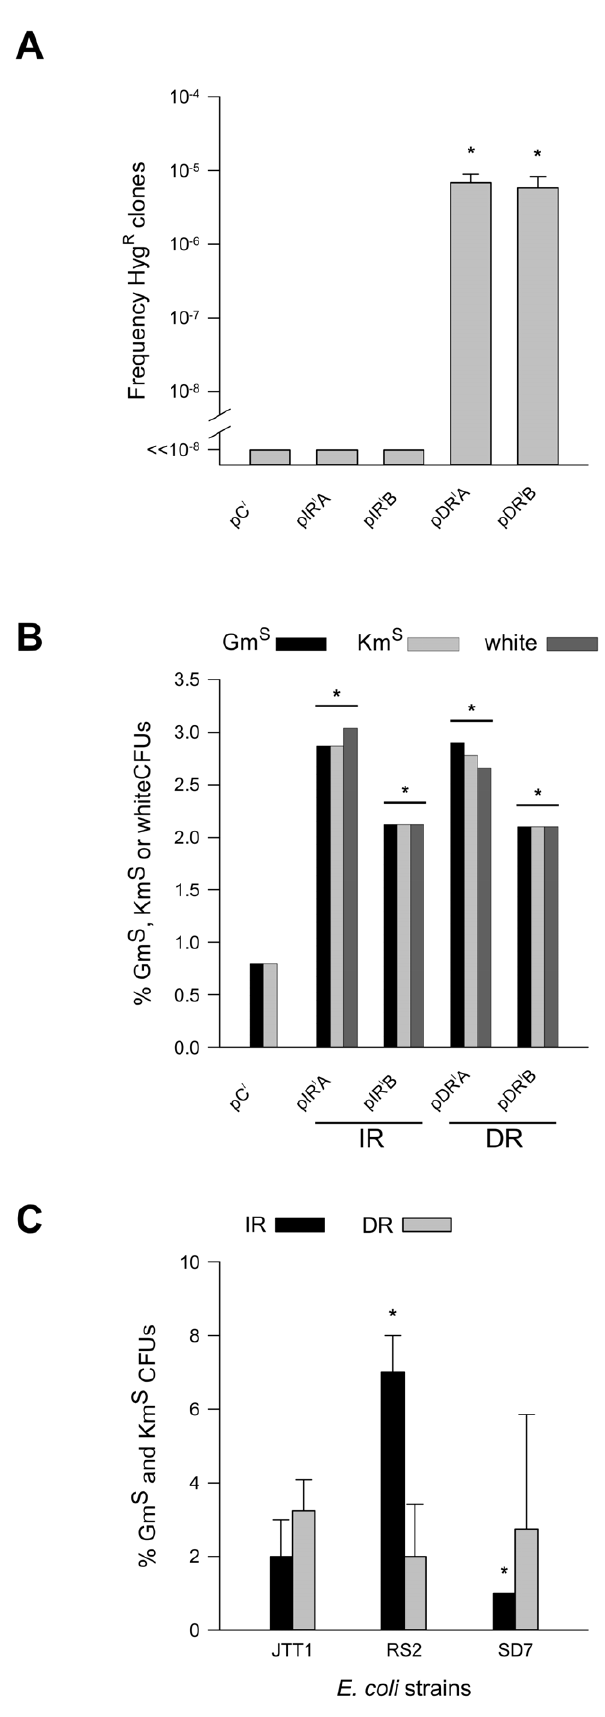
Figure 3. Oligo DR and Oligo IR induce genetic instabilities in M. smegmatis and E.coli . Panel A , reconstitution of hph (Hyg R ) gene through the precise deletion of the aacC1 (Gm R ) is only detected with the integrated Oligo DR , but not Oligo IR , in M. smegmatis . x-axis , M. smegmatis mc 2 155 strains: pC I , pMV306KmHyg::Gm (control); pIR I A , pMV306KmHyg::Oligo IR Gm A lacZ ; pIR I B , pMV306KmHyg::Oligo IR Gm B lacZ ; pDR I A , pMV306KmHyg::Oligo DR Gm A lacZ ; pDR I B , pMV306KmHyg::Oli- go DR Gm B lacZ ; y-axis , frequencies of Hyg R CFUs: asterisks , p , 0.05 (pair- wise Holm-Sidak test for pIR I A, pIR I B, pDR I A, pDR I B against pC I ). Panel B , large deletions occur in both the integrated Oligo DR and Oligo IR constructs in M. smegmatis . x-axis , as in Panel A; y-axis , percent Gm S ( black bars ), Km S ( light grey bars ), and white ( dark grey bars ) CFUs; IR , Oligo IR ; DR , Oligo DR .; asterisks , p , 0.05 ( x 2 test of pIR I A, pIR I B, pDR I A, pDR I B against pC I , z-test of pIR I A against pIR I B and pDR I A against pDR I B). Panel C , Oligo IR induces deletions in a supercoiling-dependent manner in E. coli . Percent Gm S and Km S CFUs in E. coli strains containing various steady-state levels of negative supercoil density. x-axis , E. coli strains carrying the self-replicating Oligo IR (pIR E A) or Oligo DR (pDR E A) vectors: JTT1 , wild-type; RS2 , topA mutant, higher negative supercoil density than JTT1; SD2 , topA and gyrB mutant, lower negative supercoil density than JTT1; y-axis , percent Gm S and Km S CFUs, geometric mean ( + / 2 SD) from 100 CFUs obtained from 3 independent experiments; black bars , Oligo IR (pIR E A); grey bars , Oligo DR (pDR E A); asterisks , p , 0.05 ( x 2 test of SD7 against RS2 and RS2 against